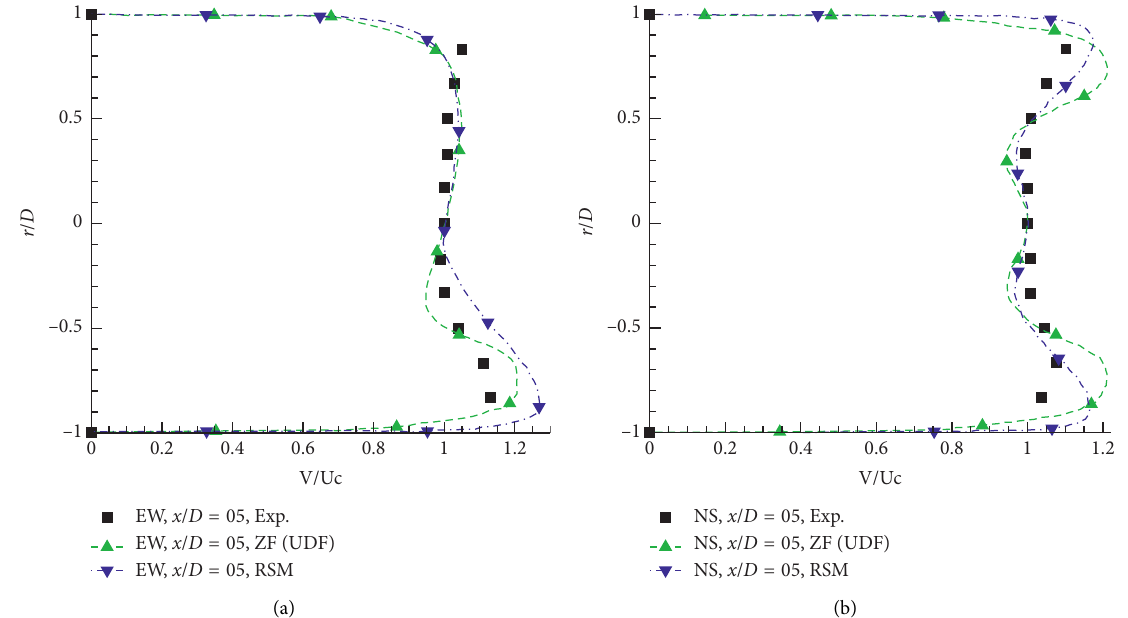
Figure 6: Normalized velocity profiles for different turbulence models at x / D � 5.